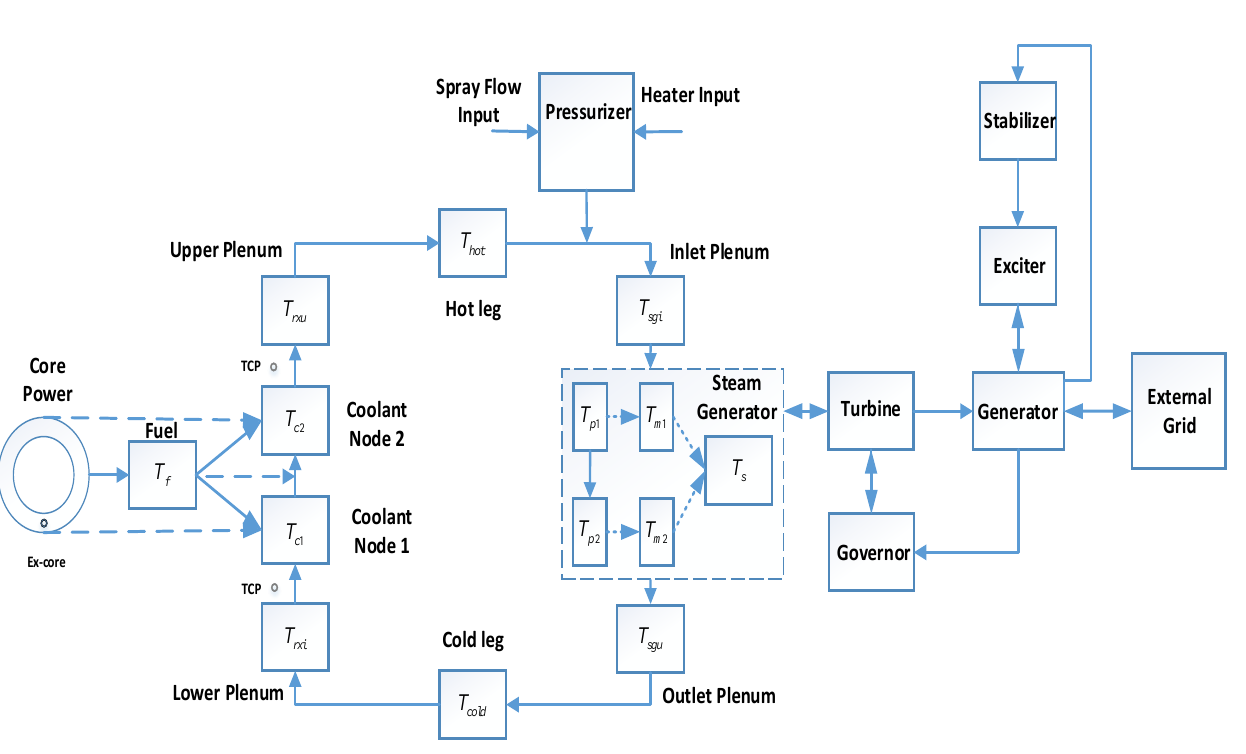
Figure 1. Block diagram representation of a pressurised water reactor (PWR)-type nuclear power plant connected to an electric